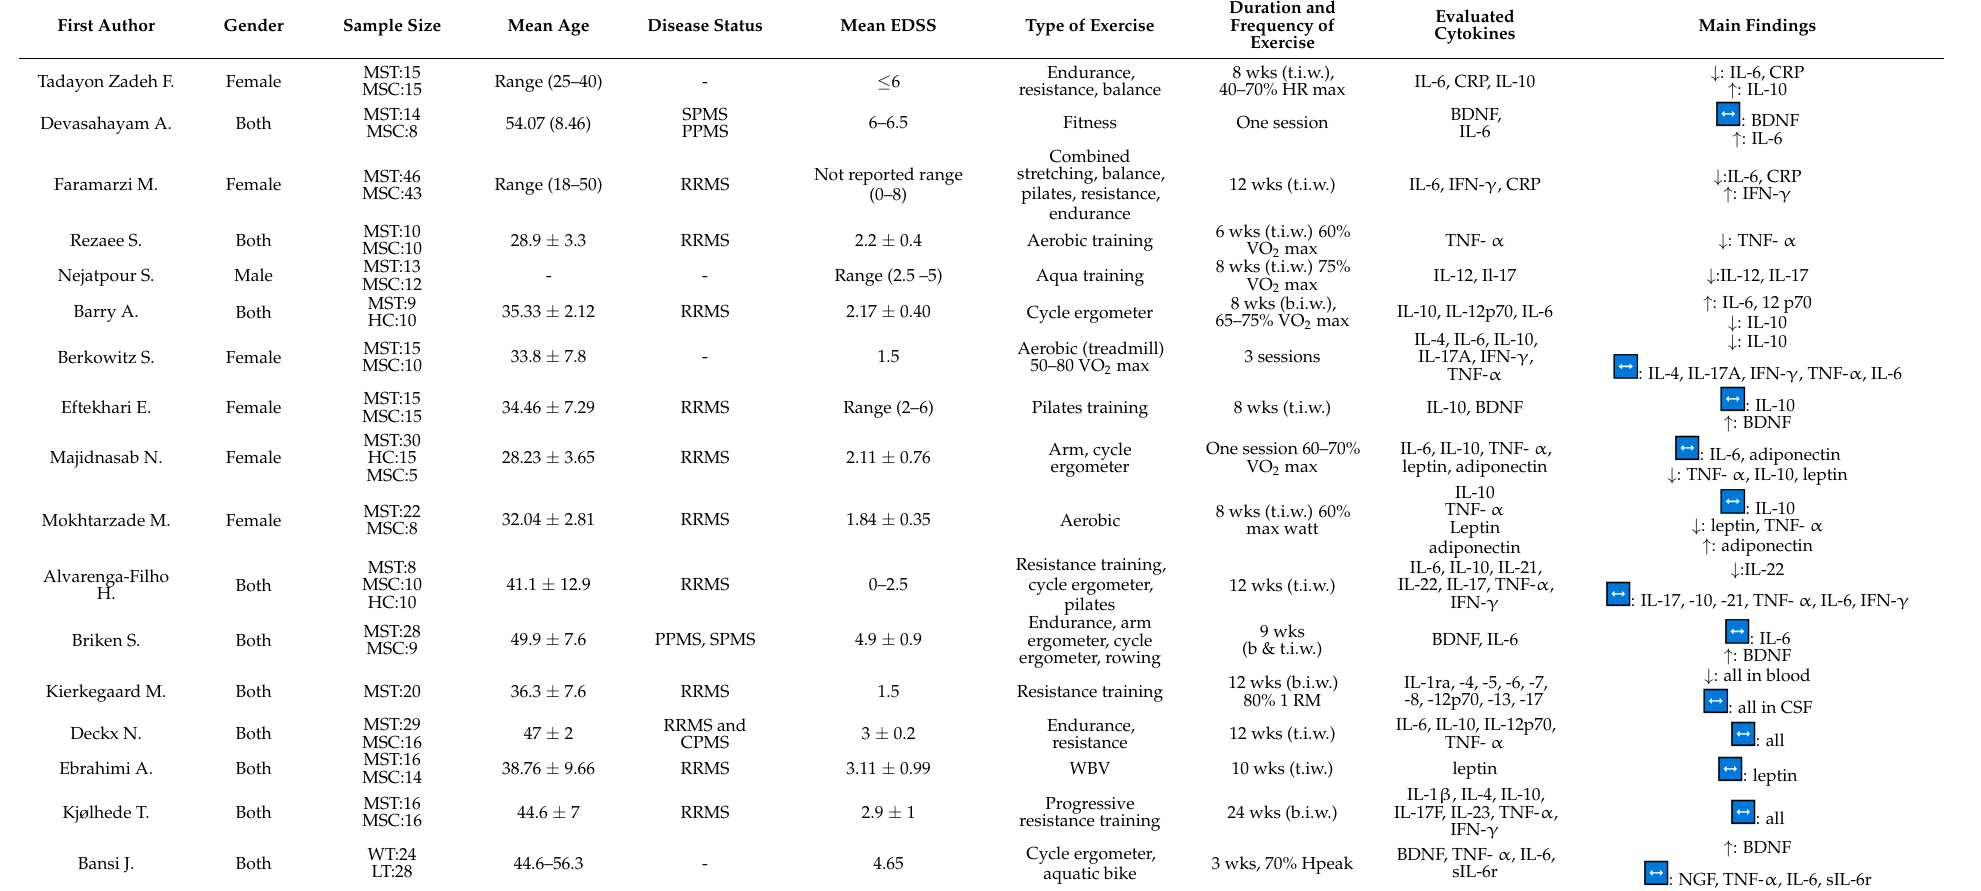
Table 2. Sample characteristics and main findings of the reviewed studies.